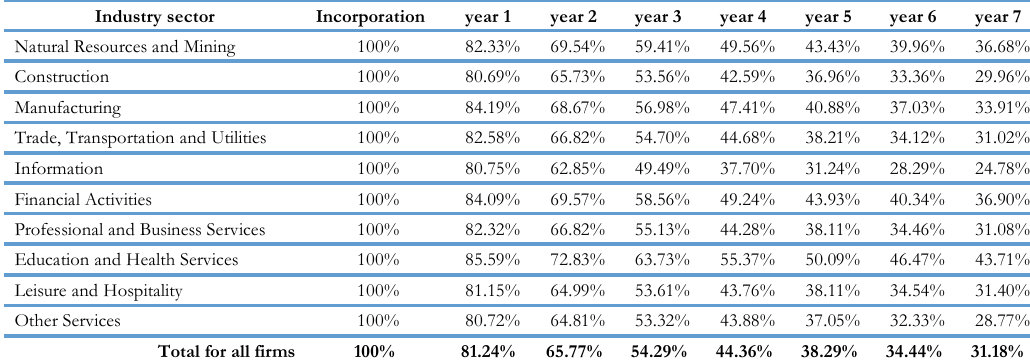
Table 1: Survival rates from the year of incorporation- US companies 1998-2005 period. (Source: Knaup & Piazza [4] and Aswath Damodaran